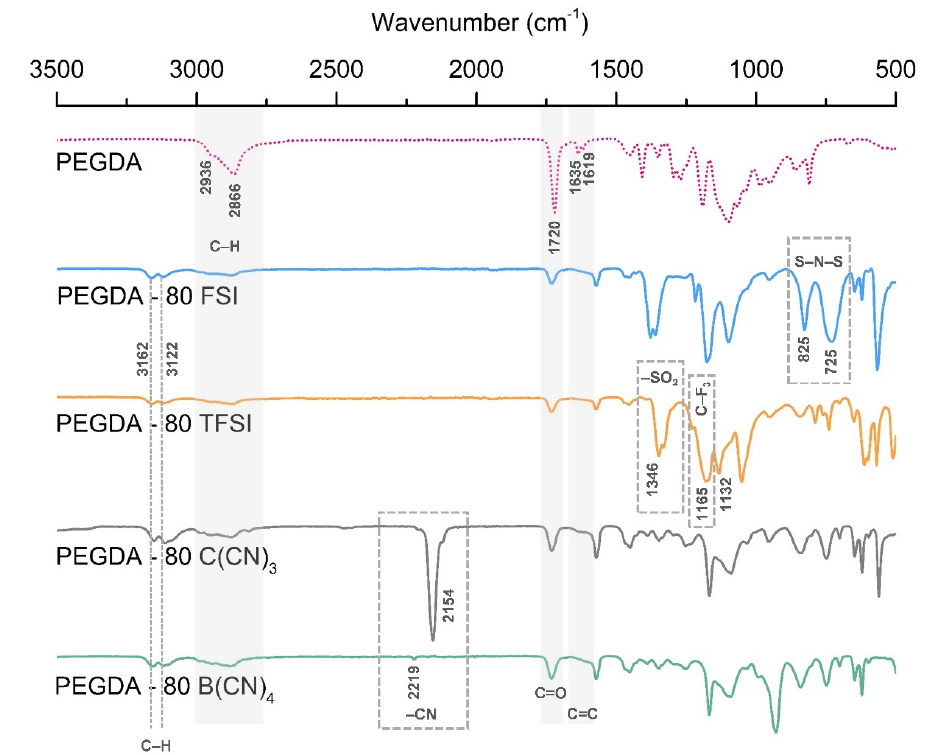
Figure 3. FTIR spectra of the pristine PEGDA and iongels (80 wt % IL) bearing different anions. The FTIR spectra obtained for PEGDA are similar to those previously published in the literature [36,42]. The presence of PEGDA in the iongels can be confirmed by the peaks observed at 1720 cm − 1 , attributed to the C=O symmetric stretching and the bands at around 2866 and 2936 cm − 1 , assigned to C-H stretching. It can also be seen that the vibration bands at 1635 cm − 1 (C=C symmetric stretching)